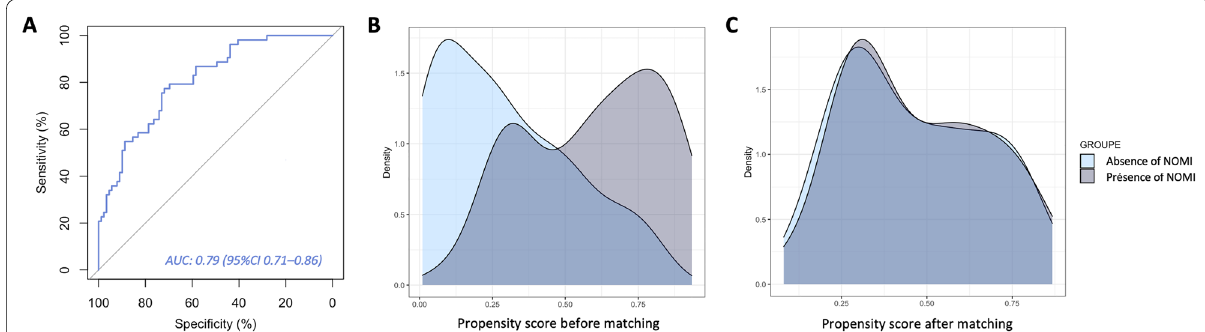
Fig. 2 A ROC curve of the propensity score for nonocclusive mesenteric ischemia prediction. B Density plot shows the propensity score distribution before propensity score matching analysis. C Density plot shows the propensity score distribution after propensity score matching analysis